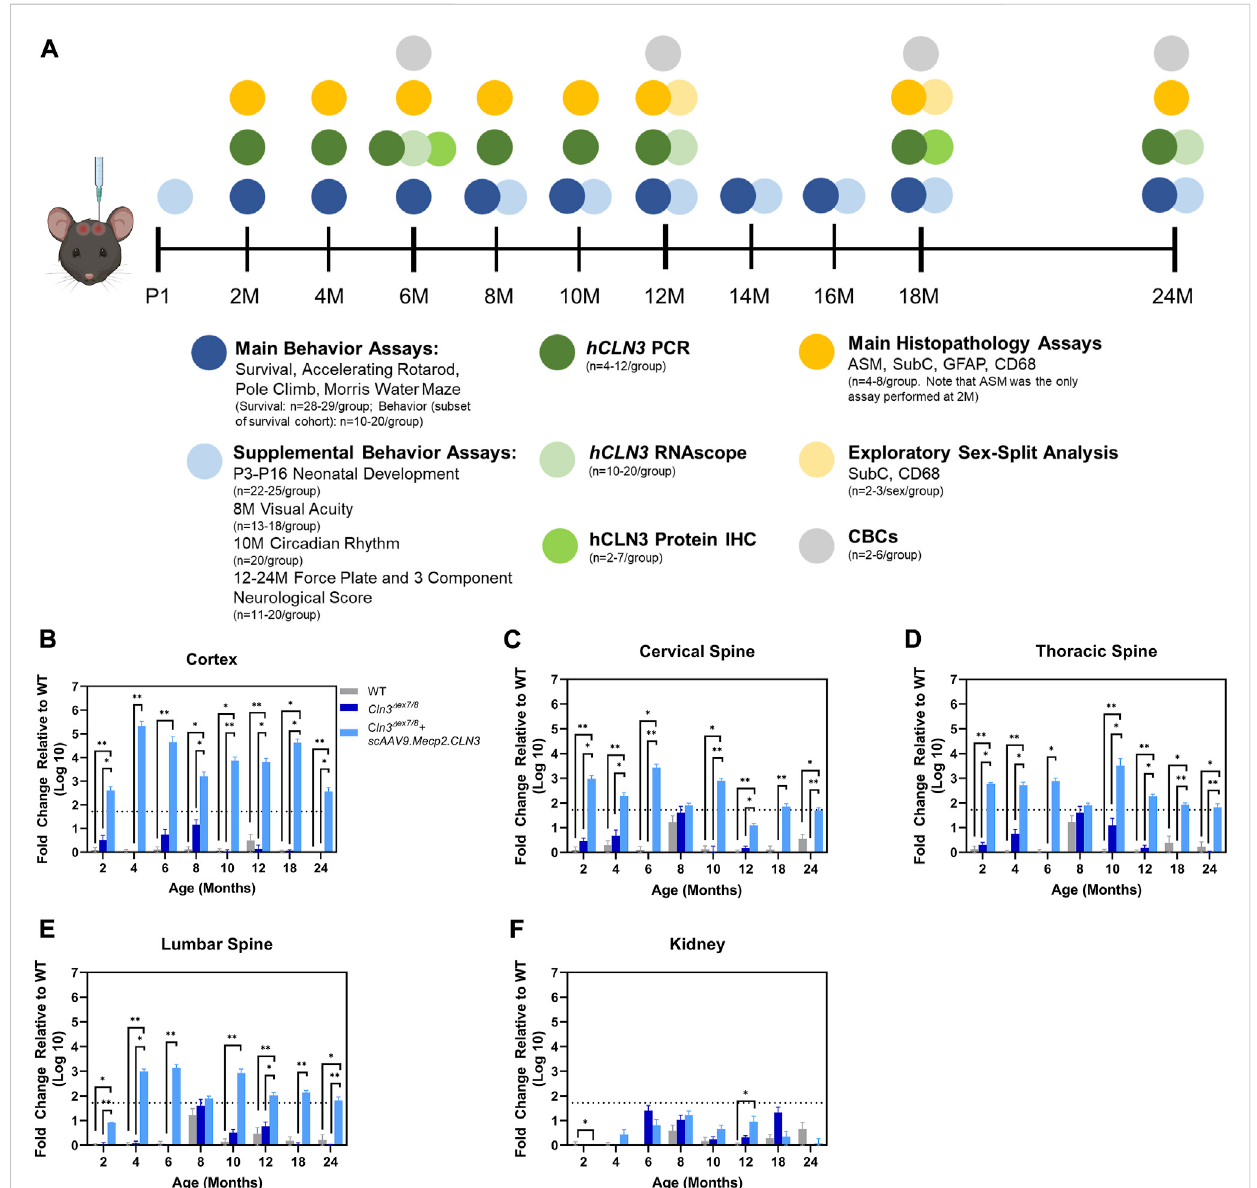
FIGURE 1 Overallstudydesignanddemonstrationof scAAV9.Mecp2.CLN3 administration resultinginhCLN3expressionthroughoutthebrainandspinal cord. Overall study design (A) . N ’ s represent mixed and even sexes unless otherwise described. As measured by RT-qPCR, hCLN3 is expressed in the cerebral cortex (B) ,cervical (C) ,thoracic (D) ,andlumbar (E) spinal cord. hCLN3 doesnotshowstrongexpression inthekidney (F) .Kruskal-Wallis,Dunncorrection at each time point, as each time point was processed independently. Mean ± SEM. * p < 0.05, ** p < 0.01, *** p < 0.001, **** p < 0.0001. For A, mouse graphic obtained from